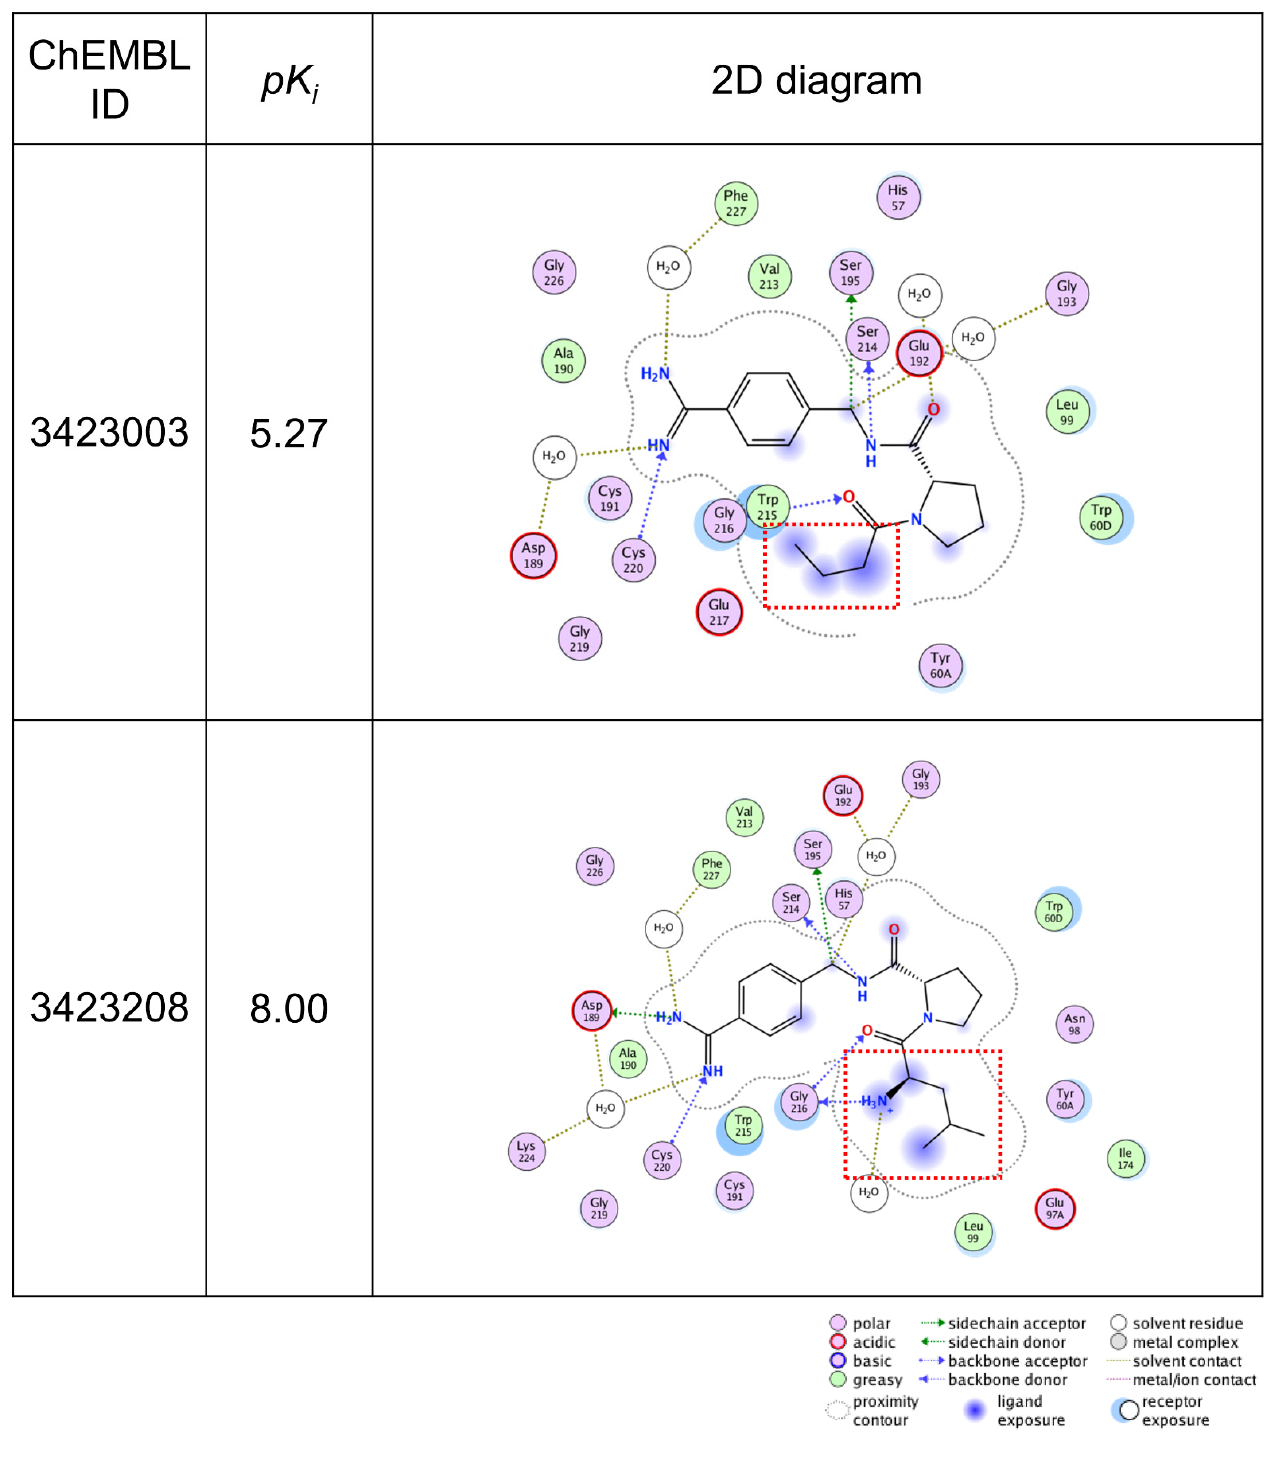
Figure 3. 2D diagrams of the thrombin–ligand interaction based on X-ray co-crystal analysis. 2D diagrams of the interaction of thrombin and the compounds that were used in the MMP in Figure 2A are illustrated. The ligand compounds are the low potency compound ( top ) and the high potency compound ( bottom ). The structural difference between the two compounds is emphasized by the red squares. The interaction pose was extracted from PDB and the diagram was generated by MOE.